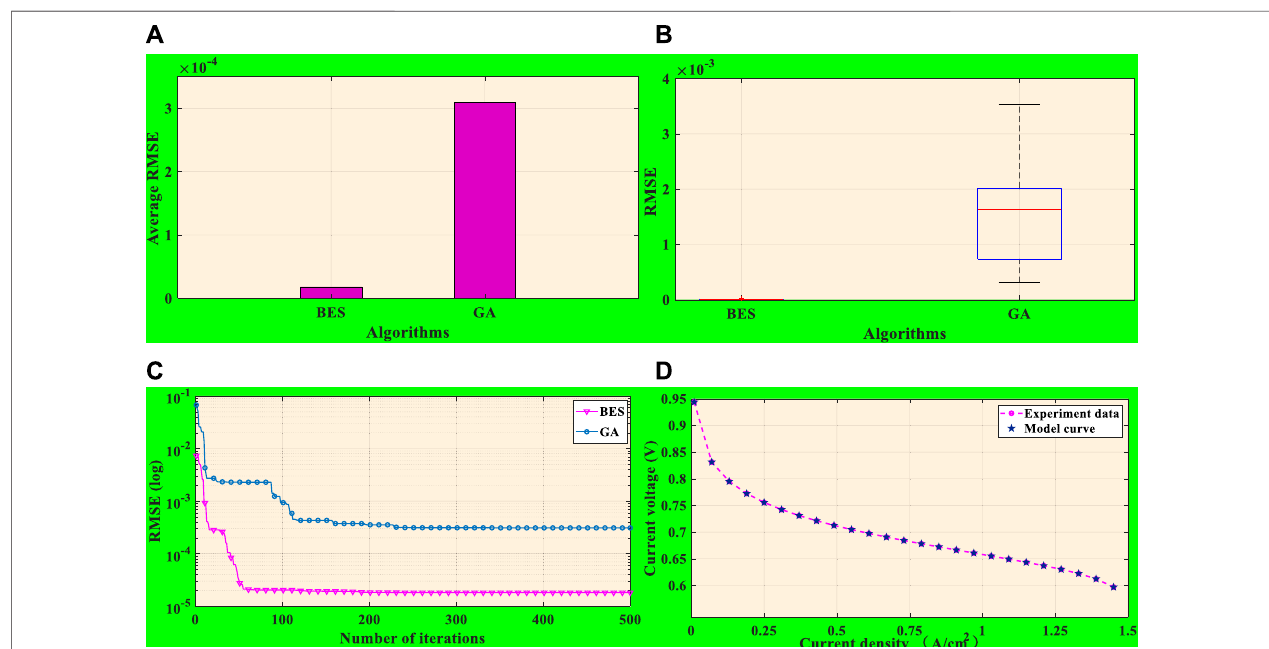
FIGURE 3 | Comprehensive analysis of BES and GA under case 1. (A) Average RMSE. (B) Boxplot of RMSE. (C) Convergence curves. (D) Comparison of model datasets by BES with experiment datasets.